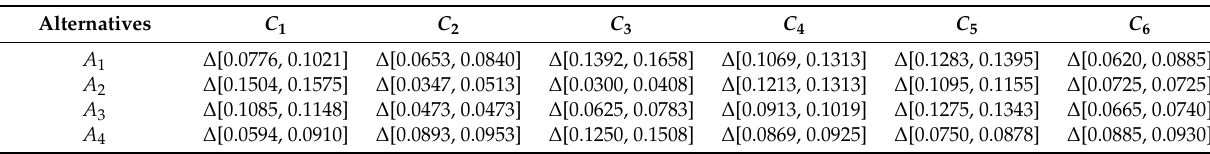
Table 5. Weighted collective interval 2-tuple decision